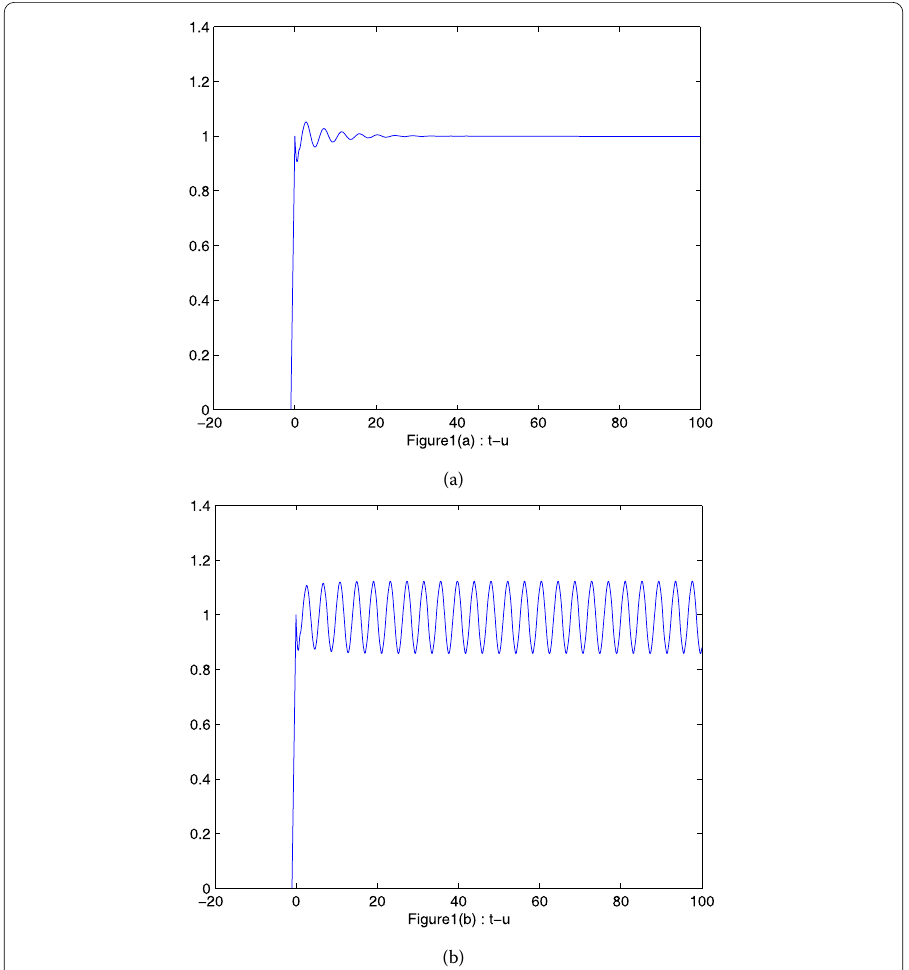
Figure 1 The numerical solution of Eq. (2.11) with PD control Euler method corresponding to k p = 0.09, k d = 0.2 when ( a ) τ = 2.5, ( b ) τ =